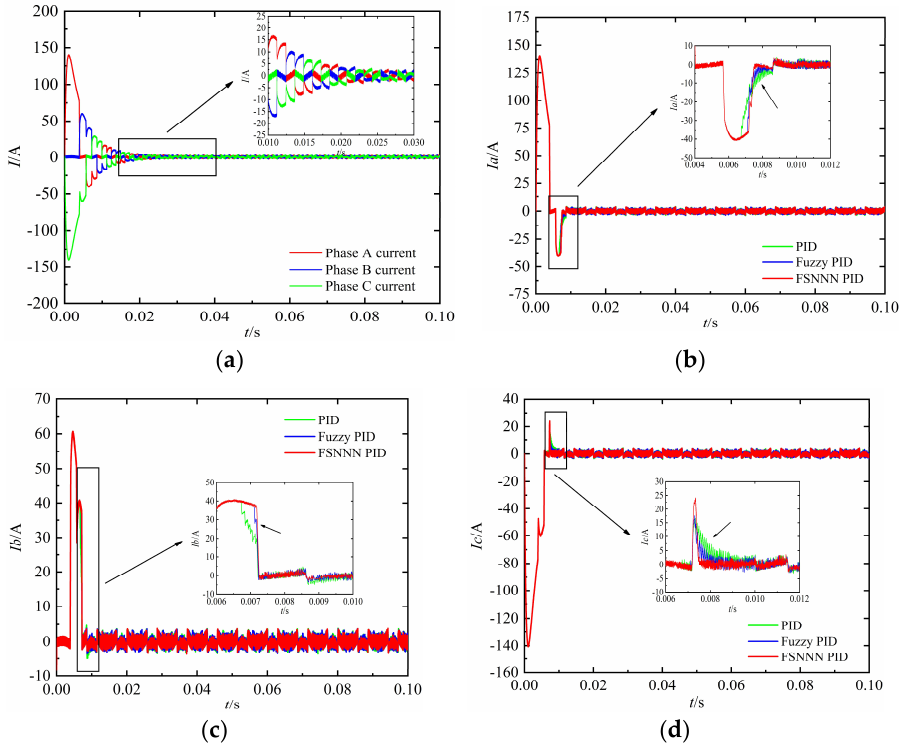
Figure 16. Current response curves at 7000 r/min under different algorithms. ( a ) Three phase current curves of motor under no-load open loop control; ( b ) phase A current; ( c ) phase B current; ( d ) phase C current.